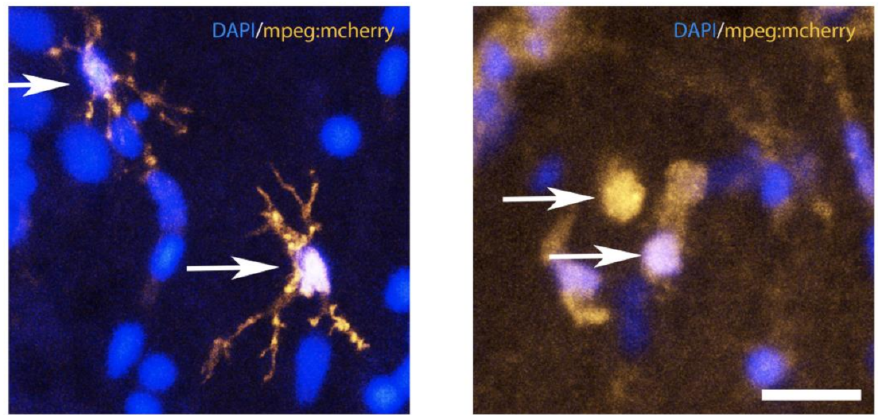
Figure 4. Resting and activated microglia under injured and uninjured (control) conditions in the telencephalon of zebrafish. Confocal microscopy showing quiescent (resting) microglia (left panel) and ameboid (activated) microglia (right panel) in the adult zebrafish telencephalon. There is an obvious change in the shape of the microglia between injured and uninjured tissue, illustrated by the mpeg :mcherry transgenic fish line, which labels microglia in the central nervous system. Arrows show the resting morphology of microglia cells (left panel) the ameboid shape of activated microglia at 1dpl (right panel). Bar: 18 µ